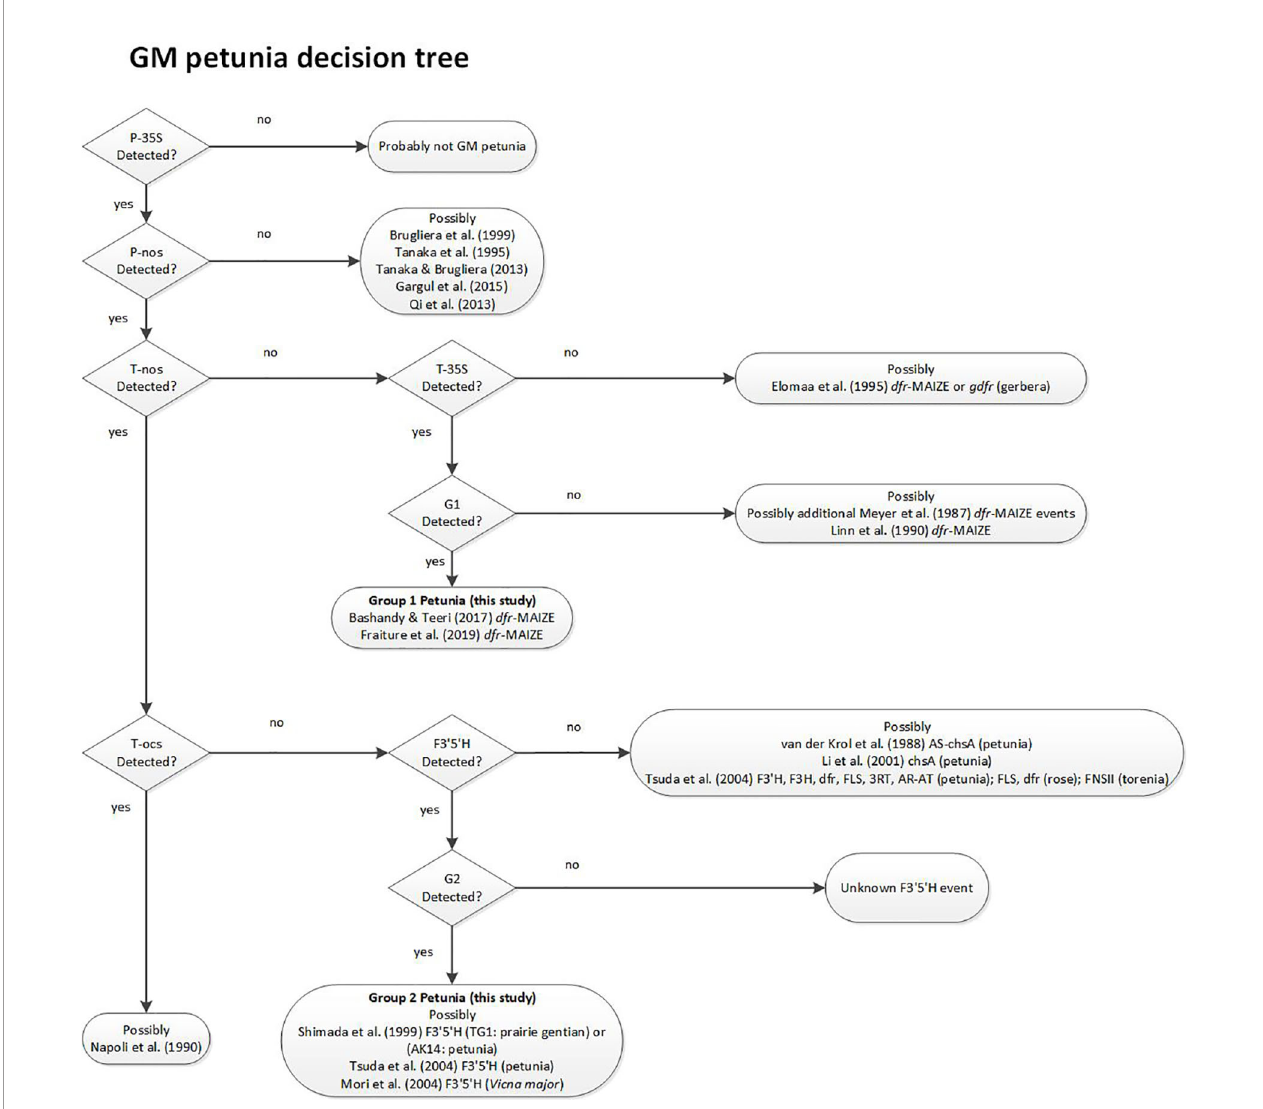
FIGURE 3 | Decision Support System (DSS) for stepwise assignment of GM petunias to the potential origin of the construct. References describing the respective construct developments for GM petunias are indicated. Decision points are based on PCR test